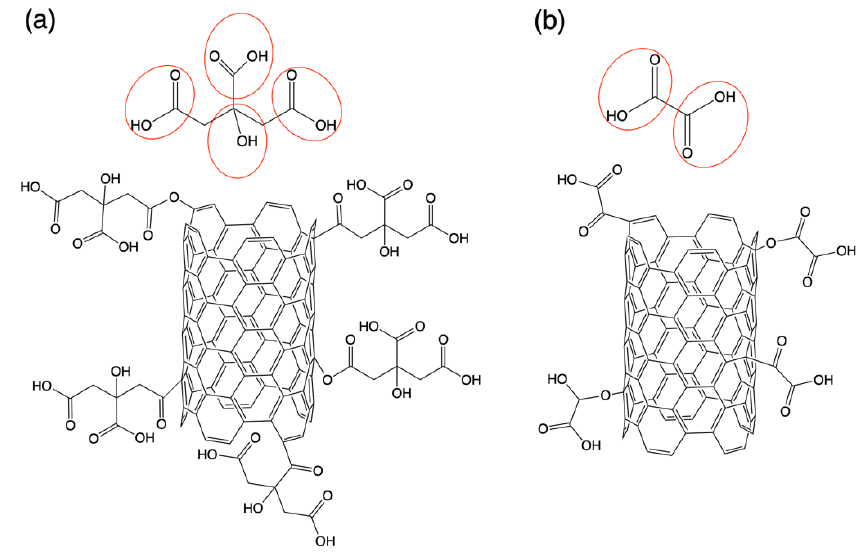
Figure 4. Possible chemical modification of MWCNT with ( a ) CA and ( b ) OA.